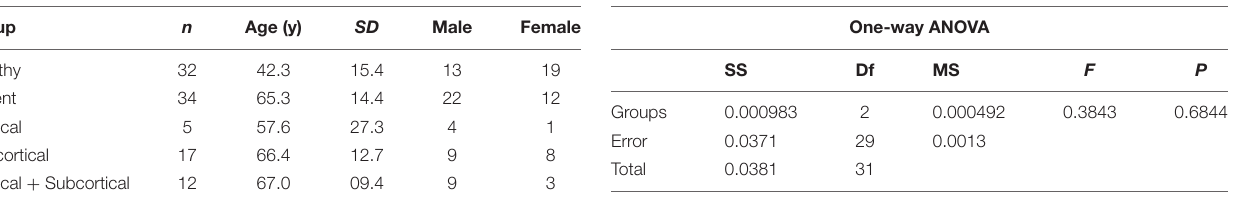
TABLE 1 | Participants’ baselines. TABLE 2 | Results of BSI-based age analysis.